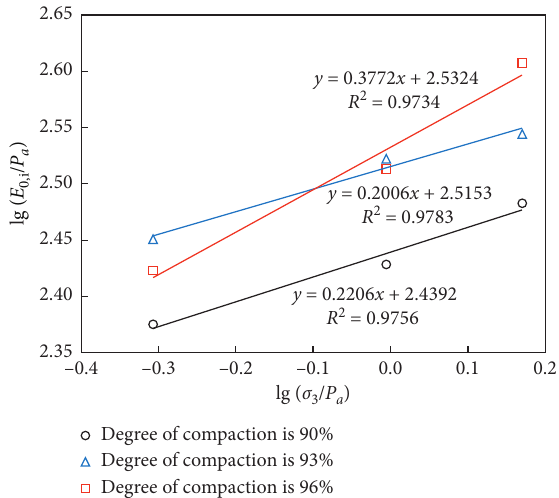
Figure 8: Relationship between lg ( E